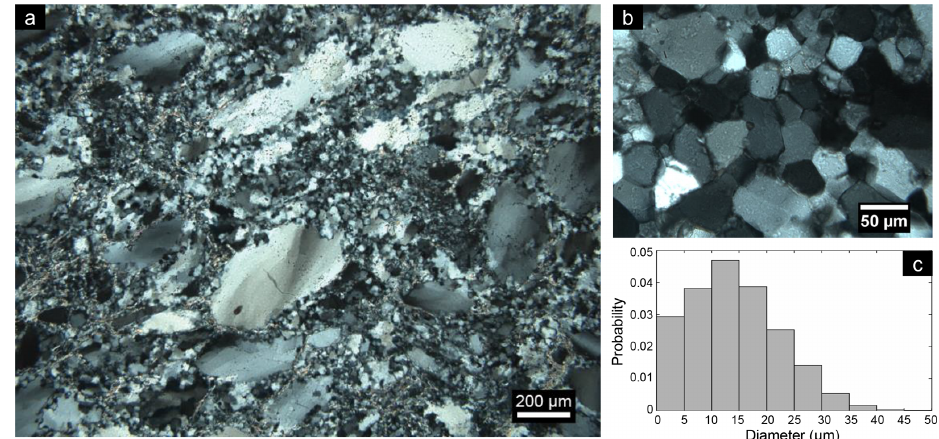
Figure 2. (a) Optical micrograph with cross-polarized light of recrystallized quartz from Feragen, as indicated by the presence of small equigranular polygonal neoblasts with straight grain boundaries together with large unrecrystallized grains with undulose extinction. This sample has not been weathered or cemented. (b) Zoomed-in view of the polygonal grains. (c) Probability density histogram of the grain size of recrystallized single quartz grains obtained from cemented rocks ( n = 1730).